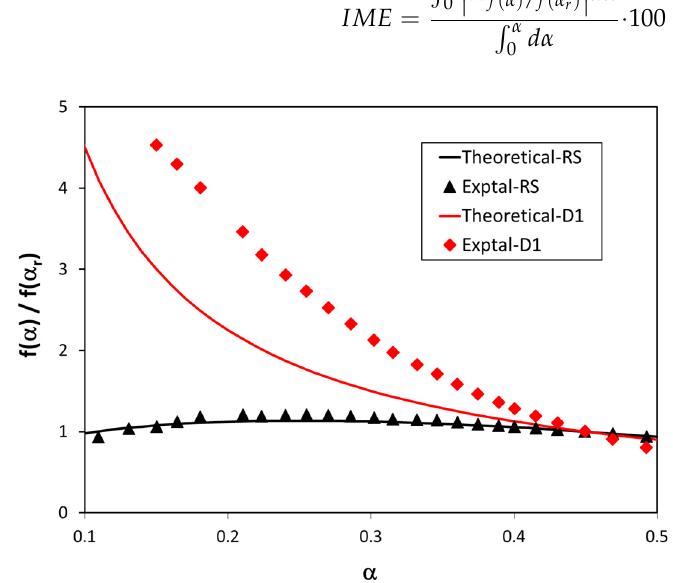
Figure 6. Variation in standardized conversion functions as a function of conversion for the thermal degradation of PLA in the bioblend containing 90% PLA, when considering two reaction mechanisms: random scission and D1.